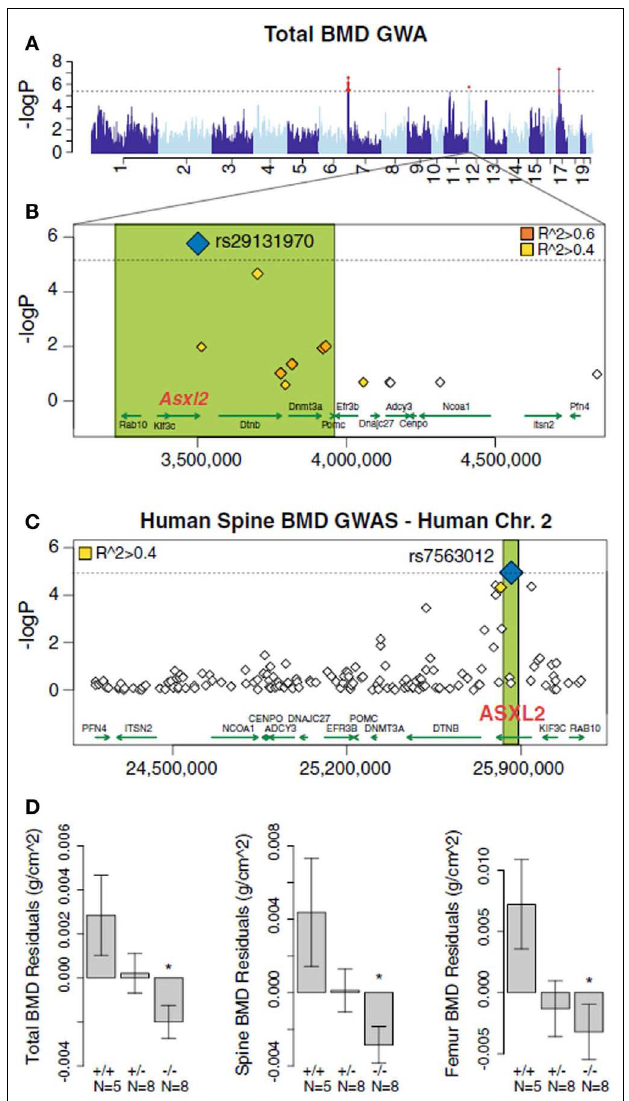
FIGURE 8 | Mapping complex clinical traits using the HMDP data in the SGR .Variation in Asxl2 in mice and humans is associated with bone mineral density (BMD). (A) A genome-wide association study in the HMDP for total BMD identified a significant region on chromosome 12. (B) A non-synonymous SNP (rs29131970) in the Asxl2 gene that was predicted to alter protein function was the most significantly associated chromosome 12 SNP in the HMDP. (C) Human SNPs within ASXL2 were also associated with BMD in roughly 6,000 Icelandic individuals. (D) Male mice deficient in Asxl2 ( − / − ) display significant decreases relative to wild-type controls in total BMD, spine BMD, and femur BMD residuals after adjusted for age and body weight. Data shown in (D) are residual mean ± SEM.